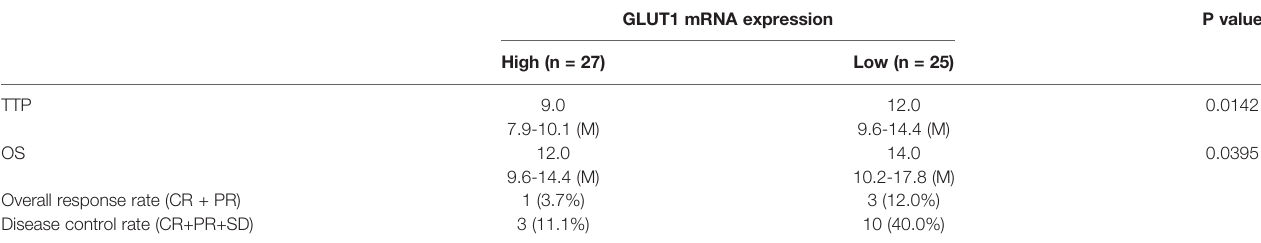
TABLE 1 | The relationship between the expression level of GLUT1 and the prognosis of patients with advanced hepatocellular carcinoma receiving sorafenib treatment.